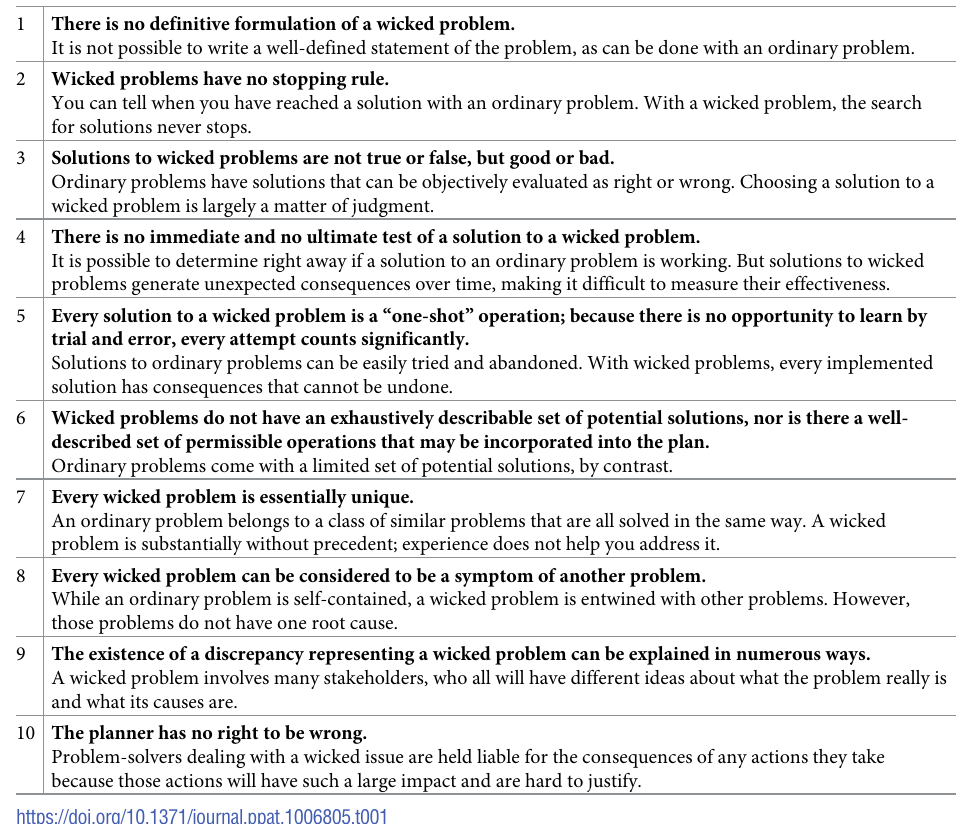
Table 1. Characteristics of a wicked